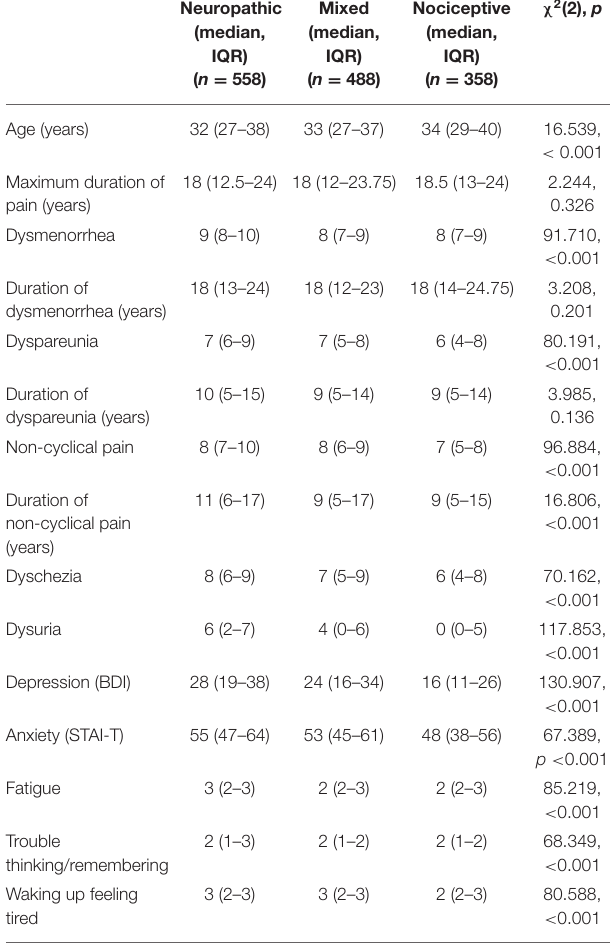
TABLE 2 | Age, numerical rating scale scores, scores of cognitive and affective measures for participants in each painDETECT group (neuropathic, mixed, and Median (range) (IQR)